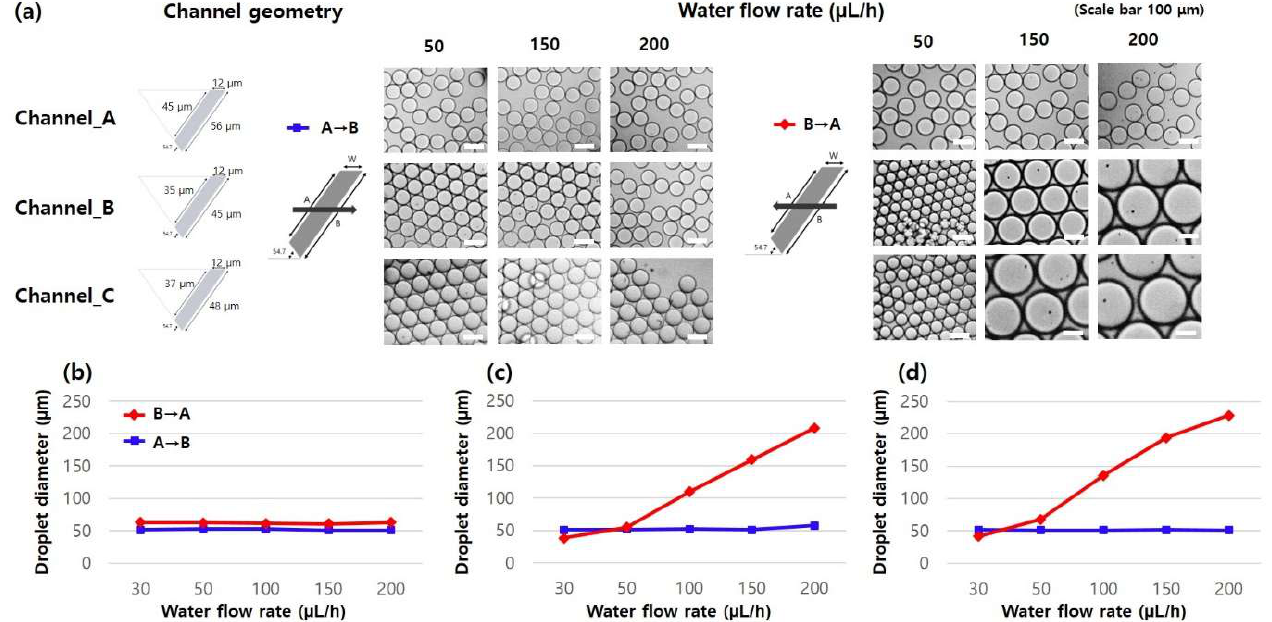
Figure 5. ( a ) Microscopic images of micro-droplets generated under various sample flow rate and oil flow direction conditions. Average diameters of micro-droplets generated in ( b ) Channel_A, ( c ) Channel_B, and ( d ) Channel_C designs. The oil flow rate was fixed at 200 µL/h.